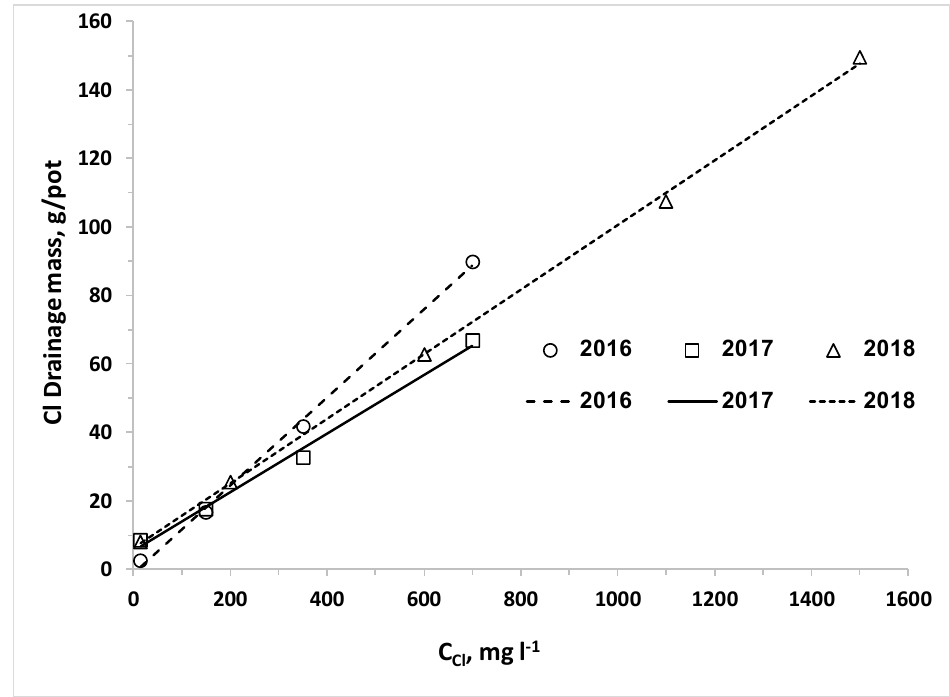
Figure 6. M Cl as function of C Cl in three potato experiments: 2016, 2017, and 2018. The equations of best fit curves of Cl-Drainage mass (M ClL ) vs. Cl irrigation concentration (C Cl ) are presented in Figure 5 are as follows: 2016, Y = 0.1285X − 1.34, R2 = 0.998. 2017, Y = 0.086X + 5.33, R2 = 0.998. 2018, Y = 0.0944X + 6.15, R2 =